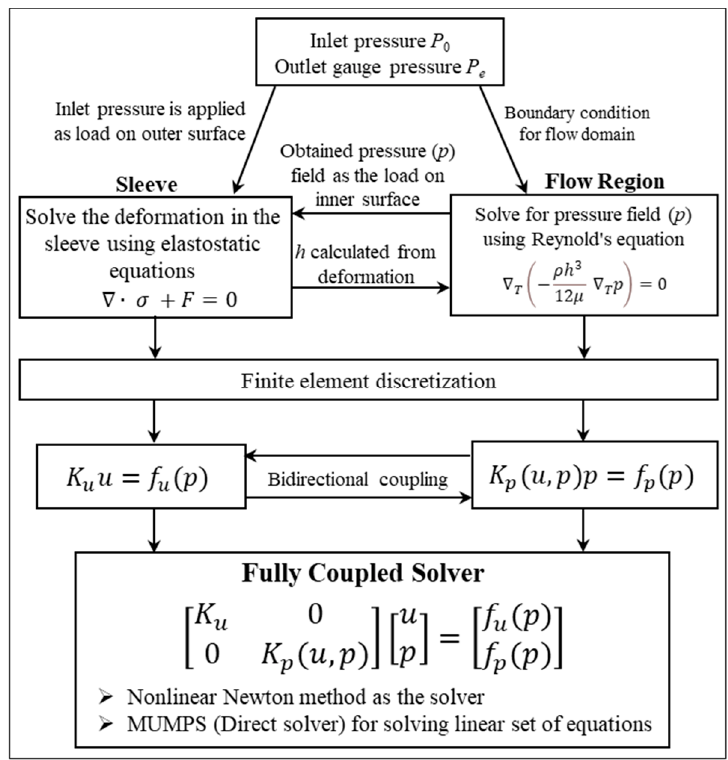
Figure 4. Flowchart for fully coupled simulations .